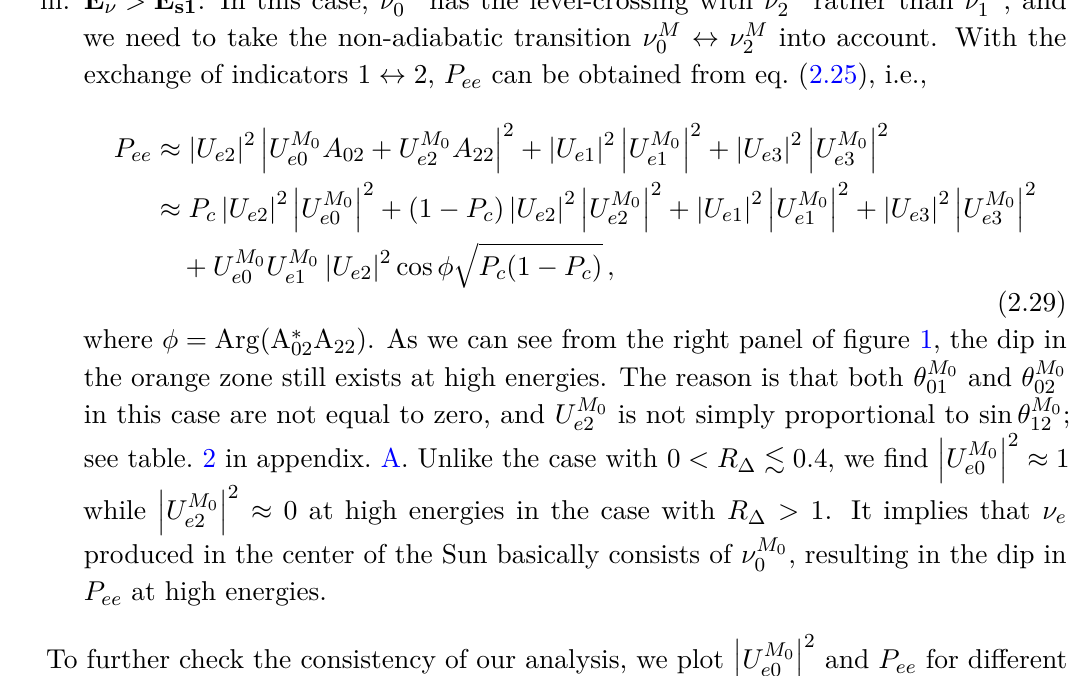
(cid:12) (cid:12) 2 as a function of neutrino energy and R Figure 3 . Upper panels: (cid:12) U M e 0 (cid:12) curves correspond to E + (0) ( E − (0) ) calculated by eq. (2.20). Lower panels: The survival probability s s as a function of neutrino energy for different R ∆ . The left (right) panels correspond to 0 < R ∆ . 0 . 4 ( R ∆ > 1 ). Here sin 2 2 θ 01 is set to be 5 × 10 − 4 , and other oscillation parameters not shown are the same as those in figure